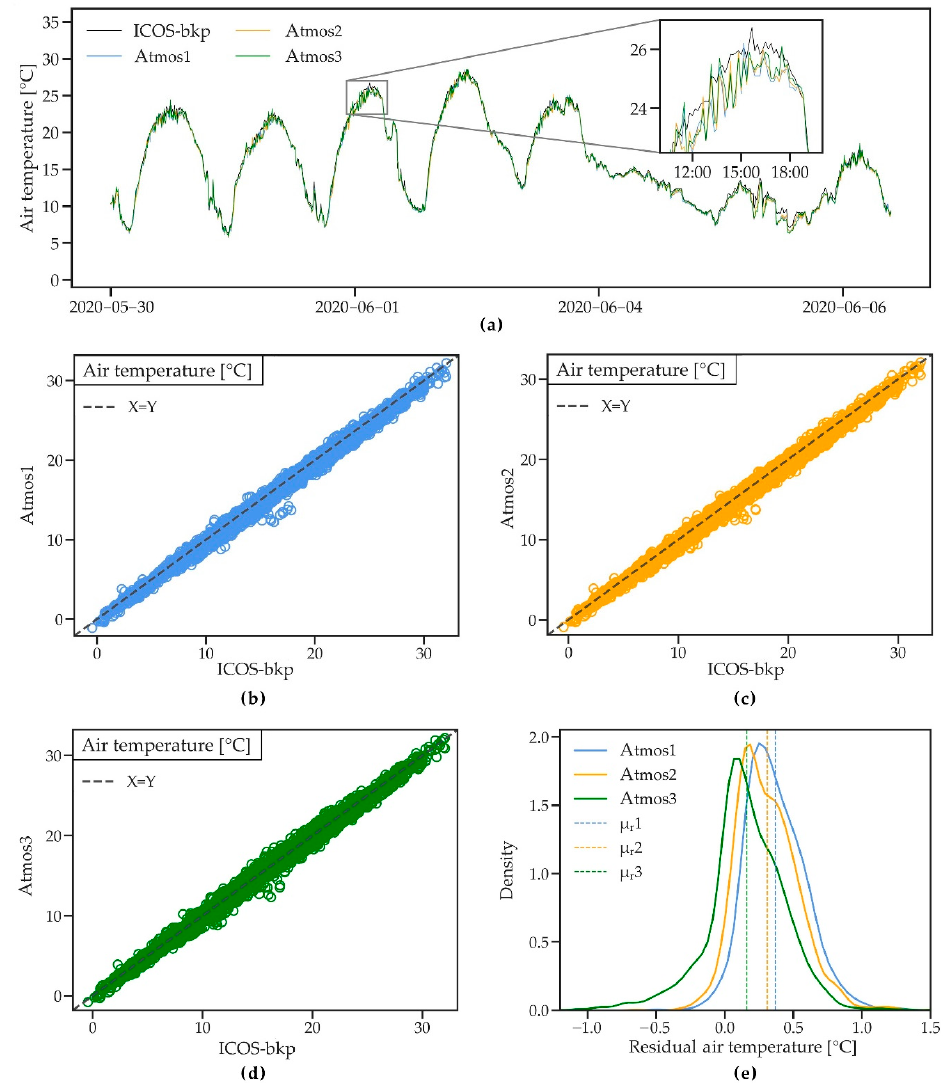
Figure 6. ( a ) A short time series of air temperature measured by three ATMOS41 weather stations and the ICOS-bkp station from 30 May to 6 June 2020. ( b – d ) Scatterplots of 10 min air temperature for the three ATMOS41 stations vs. the reference station. ( e ) Probability density functions of the residual mean hourly air temperature. Dashed lines show the mean of residuals ( μ r ).